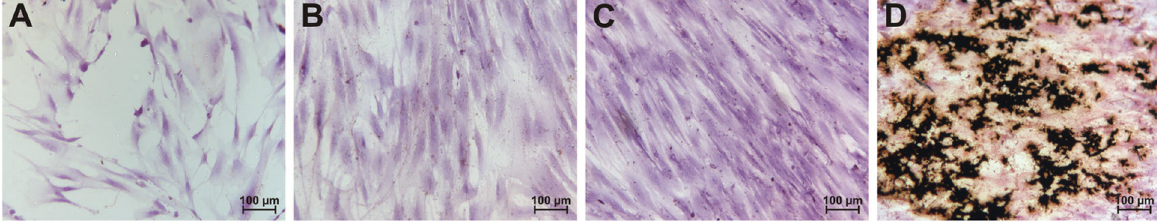
Figure 1. Mesenchymal stromal cells (MSCs) were cultured in osteoblastic differentiation medium and stained by the von Kossa method at 1 day ( A ), 3 days ( B ), 7 days ( C ), and 14 days ( D ). von Kossa staining showed mineralization nodules (black) and MSCs morphology changed from spindle to cuboid shape after 14